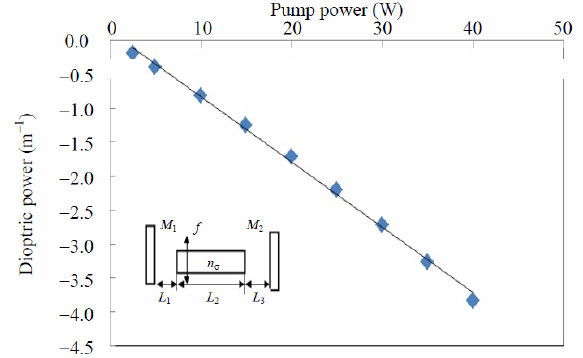
Fig. 4 Calculations of dioptric power of thermally induced lens (  -polarization) in Nd: YLF laser rod versus pump power.